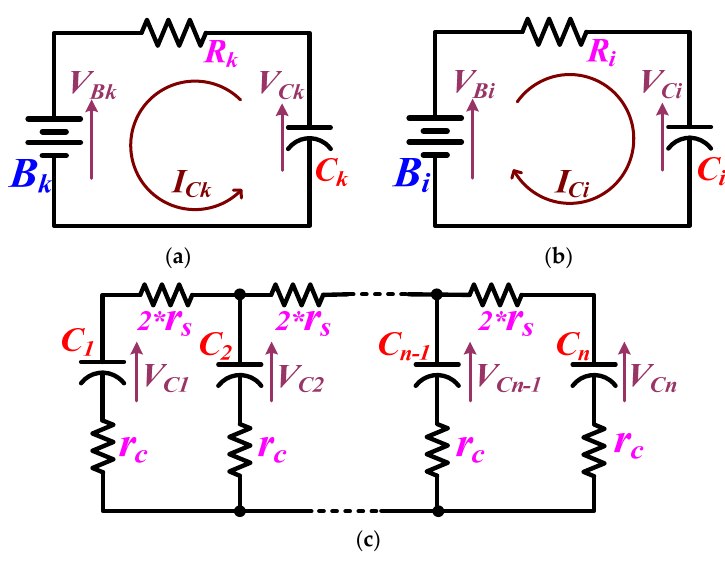
Figure 3. State circuits of the proposed voltage equalization system: ( a ) during phase Φ 1 when V Bk < V Ck ; ( b ) during phase Φ 1 when V Bk > V Ck ; ( c ) during phase Φ 2 .